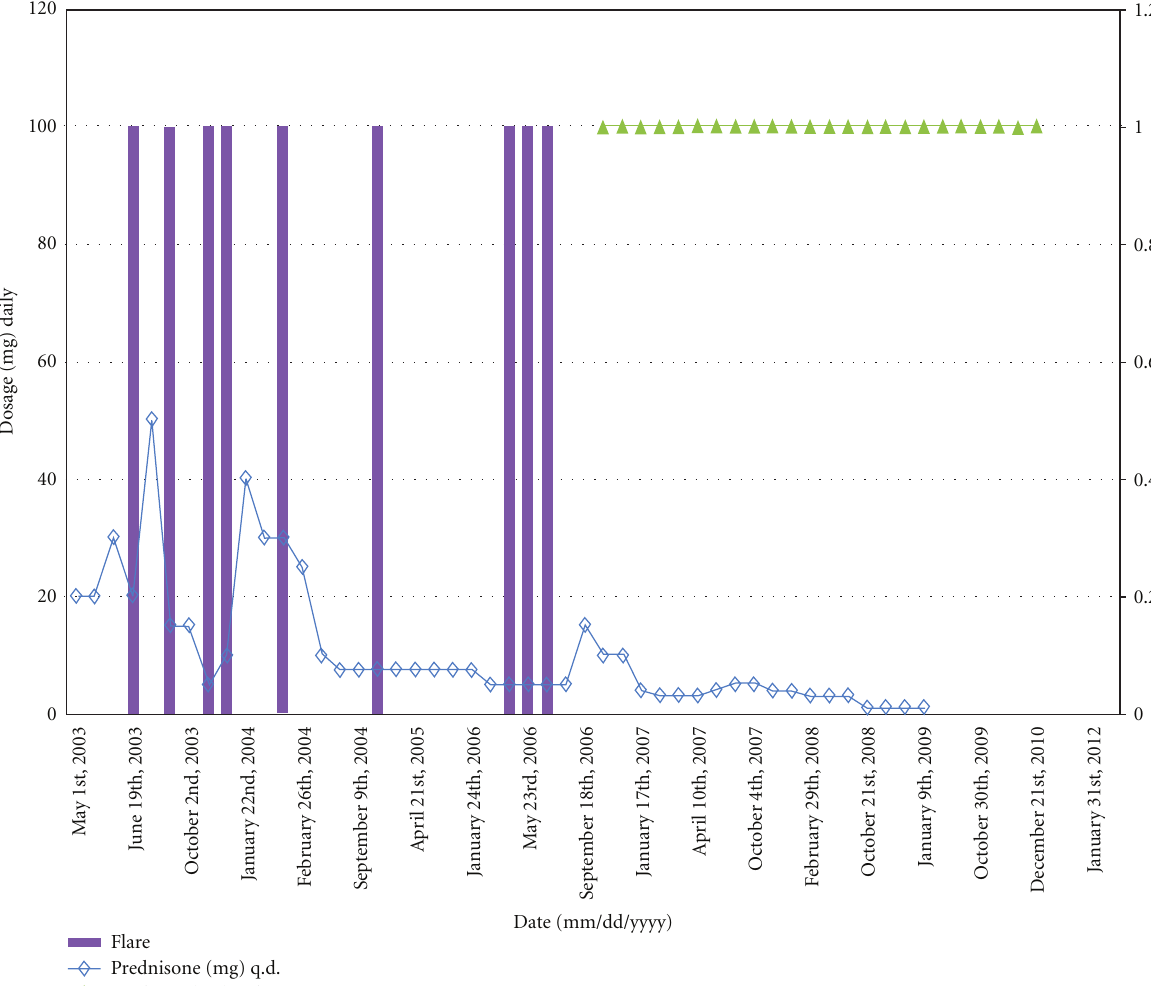
Prednisone (mg) q.d. Figure 1: Improvement in flares and the decline of the prednisone dose after initiation of